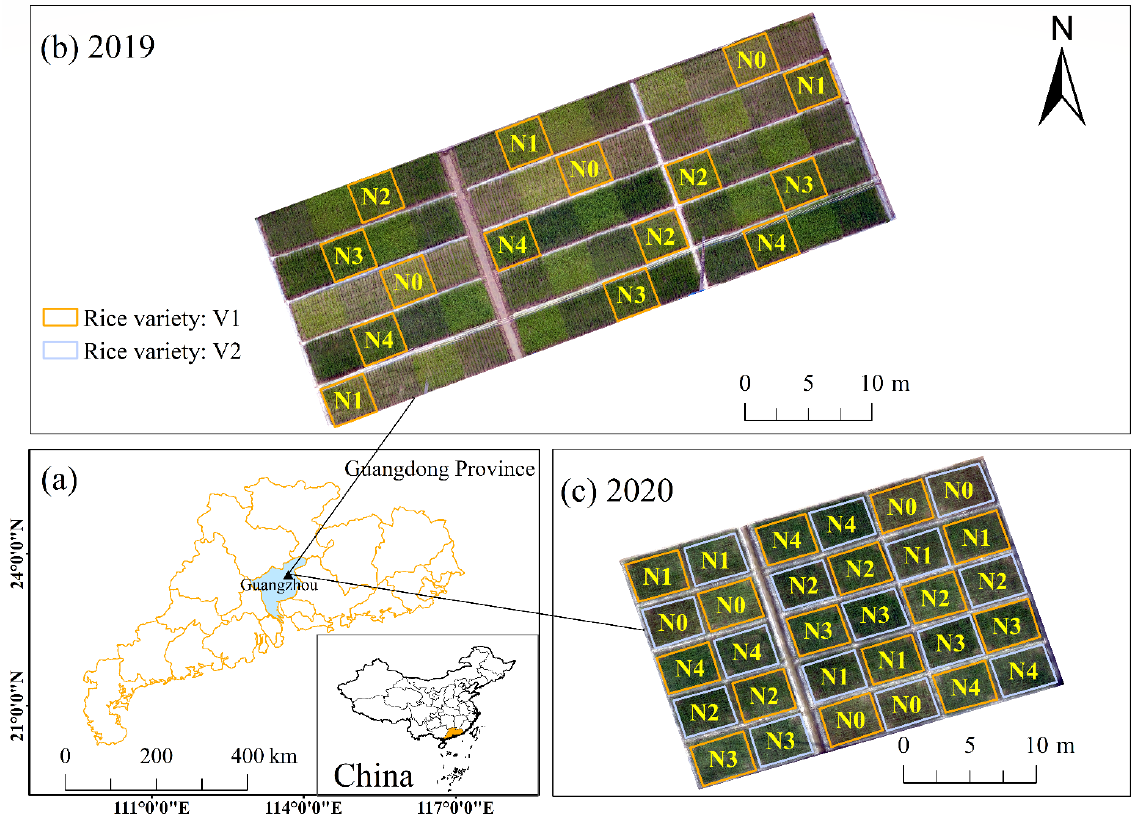
Figure 1. Study area and plot design for 2019 and 2020 experiments. ( a ) Location of test area, ( b ) Plot test map in 2019, ( c ) Plot test map in 2020.